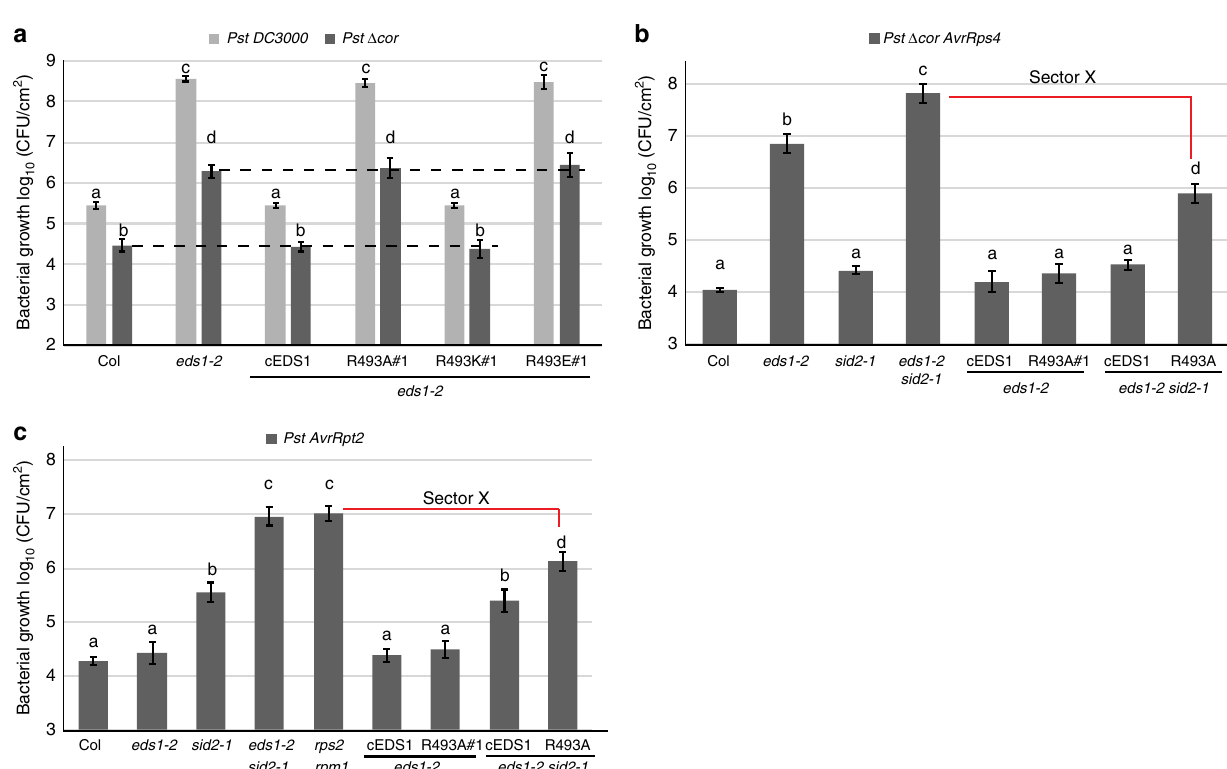
Fig. 6 EDS1 R493 signals in TNL and CNL ( RPS2 ) immunity. a Four-week-old Arabidopsis plants of the indicated genotypes were in fi ltrated with Pst DC3000 and Pst Δ Cor (OD 600 – 0.0005). Bacterial titres were determined at 0 and 3 dpi. No signi fi cant difference was observed between lines and treatments at 0 dpi. Bars represent mean of four biological replicates ± SE. Differences between genotypes were analysed using ANOVA (Tukey ’ s HSD, p < 0.005). Similar results were obtained in three independent experiments. b Four-week-old Arabidopsis plants of the indicated genotypes were in fi ltrated with Pst Δ Cor AvrRps4 (OD – 0.0005). Bacterial titres were determined at 0 and 3 dpi. No signi fi cant difference was observed at 0 dpi. Bars represent mean of four 600 biological replicates ± SE. Differences between genotypes were analysed using ANOVA (Tukey ’ s HSD, p < 0.005). Similar results were obtained in three independent experiments. c Four-week-old Arabidopsis plants of the indicated genotypes were in fi ltrated with Pst AvrRpt2 (OD 600 – 0.0005). Bacterial titres were determined at 0 and 3 dpi. No signi fi cant difference was observed at 0 dpi. Bars represent mean of four biological replicates± SE. Differences between genotypes were analysed using ANOVA (Tukey ’ s HSD, p < 0.005). Similar results were obtained in three independent